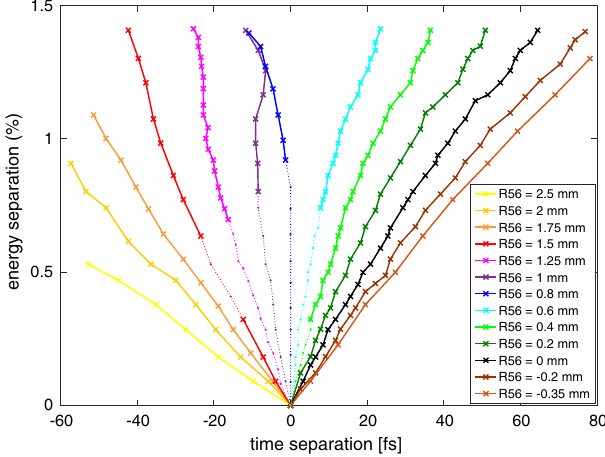
FIG. 7. Tuning range of time and energy separation as a function of the R 56 of the energy collimator. Continuous lines connect points which have current spikes within the defined current limits. Dashed lines connect points which have current spikes larger than 10 kA, and from which two-color FEL radiation is only enabled when the radiating slices are trans- versely separated from the rest of the beam.